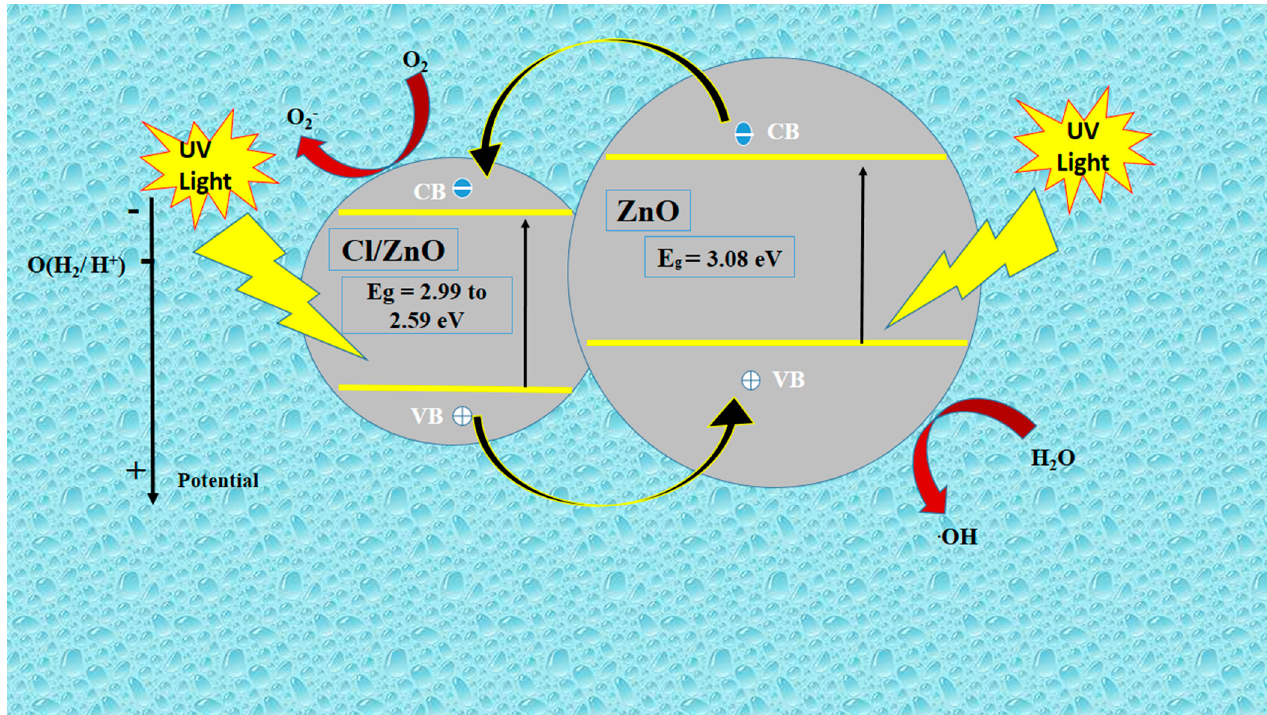
Scheme 1. Photodegradation mechanism of MB under the illumination of UV light.